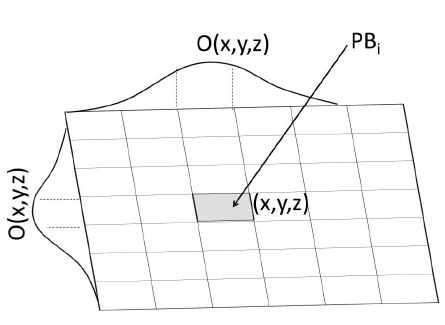
Fig. 6. Schematic representation of dose deposition into a particular voxel (x,y,z) from the PB i . The lateral Gaussian- shaped curves represent the lateral penumbra of the PB